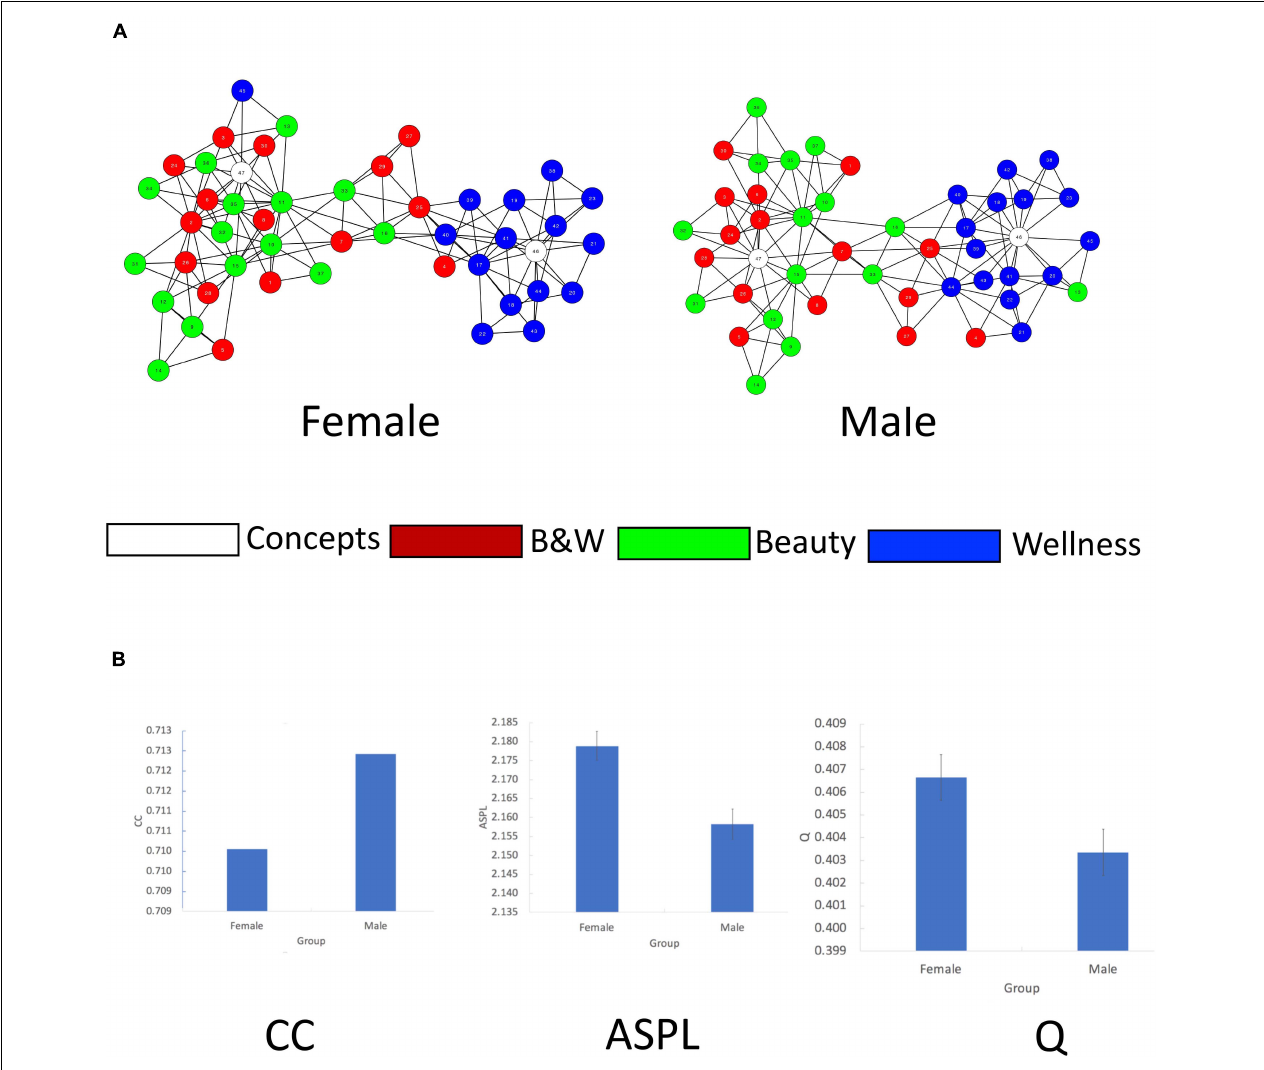
FIGURE 3 | Network analysis for Sex. (A) 2D visualization of the Sex 47 cue words (nodes) semantic networks. Edges denote symmetrical, binary relations between nodes. Colors represent category membership. Node numbers correspond to their word labels that appear in Appendix Table A1 . (B) Bootstrapping analysis of CC, ASPL, and Q for the Sex groups. X -axes–Group, Y = axes–network measure (CC, ASPL, and Q)